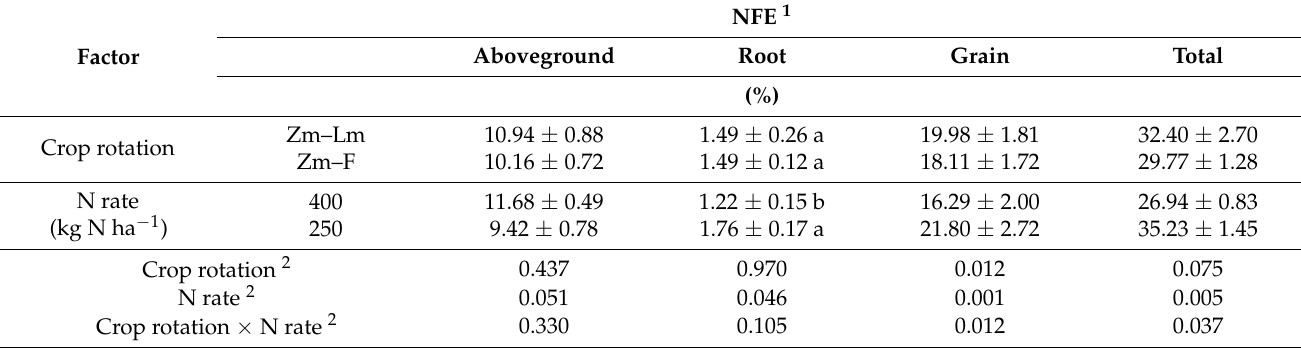
Table 4. Nitrogen fertilizer efficiency (NFE) in the aboveground, root, grain, and total maize plant.